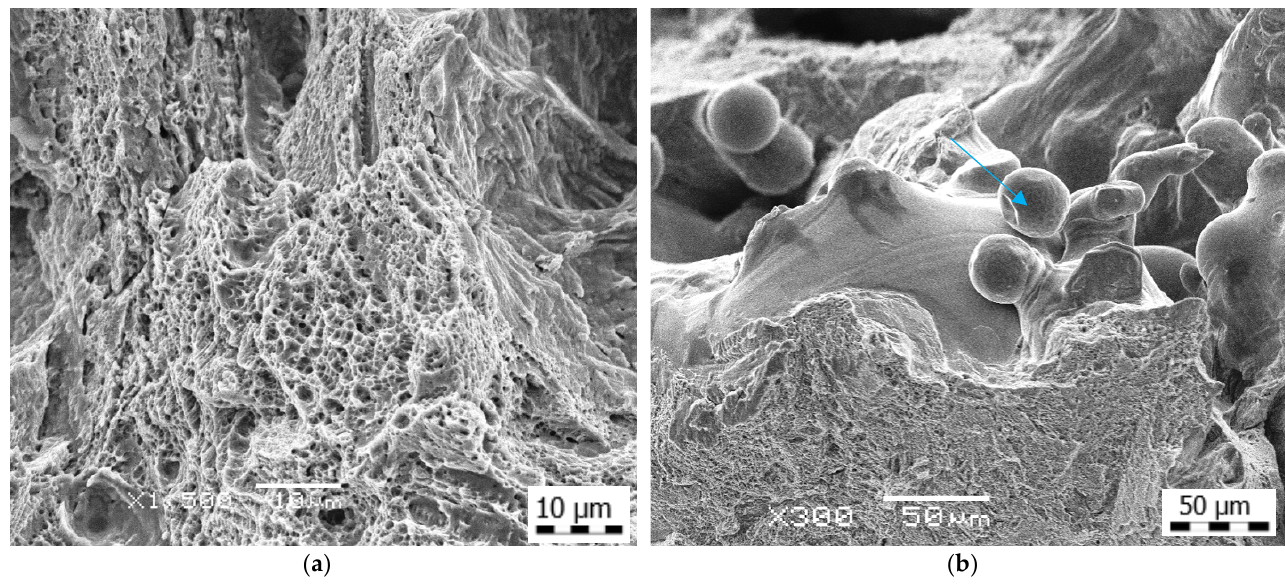
Figure 12. Fracture surface of 3D Charpy V-notch test: ( a ) transgranular fracture; ( b ) defects on the fracture surface, blue arrow shows unmelted metal particles.